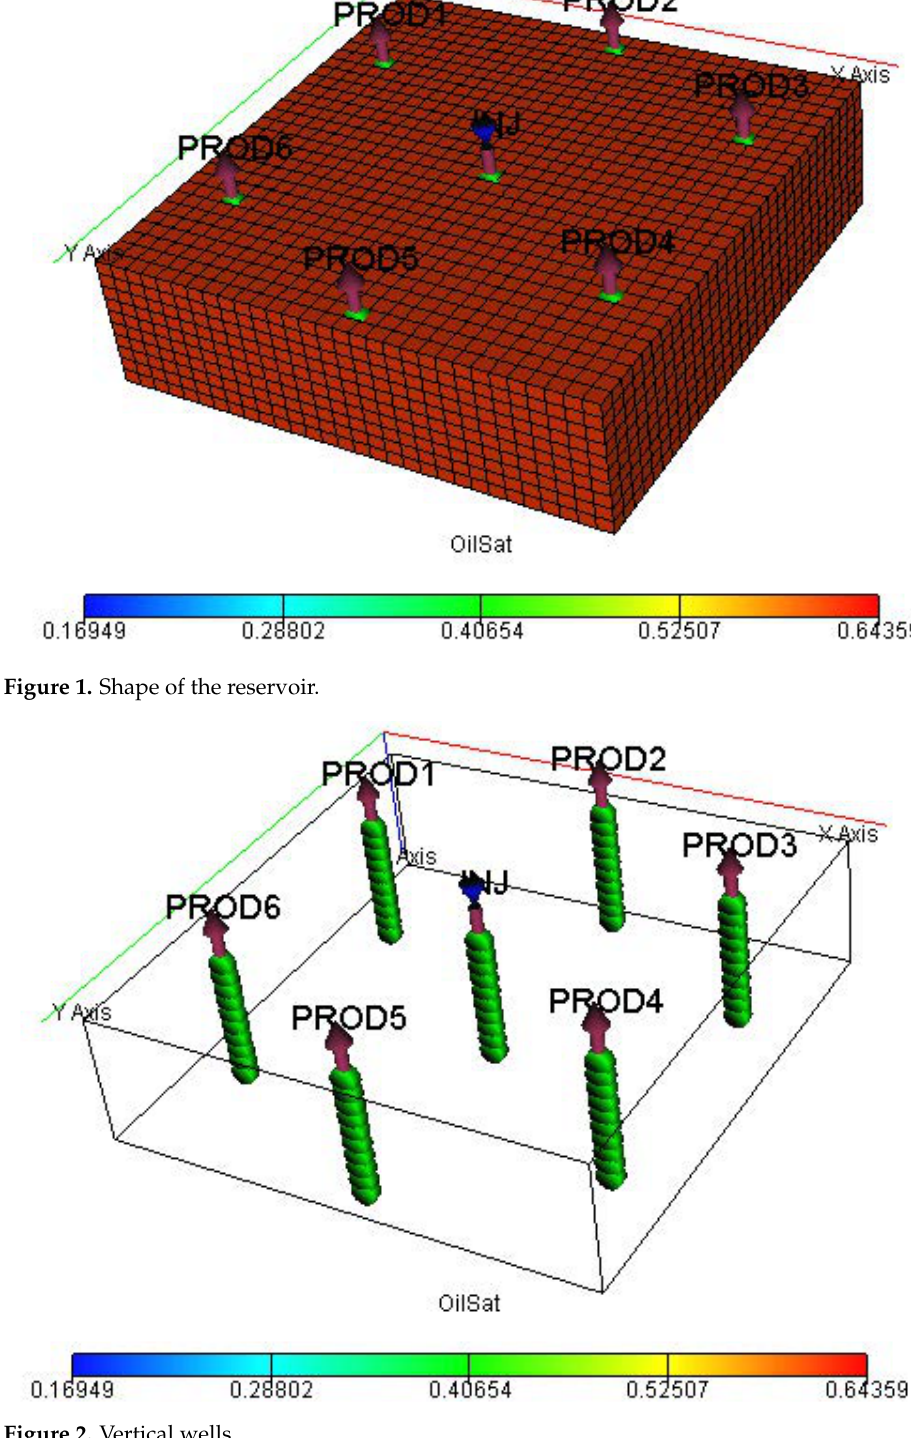
Figure 2. Vertical